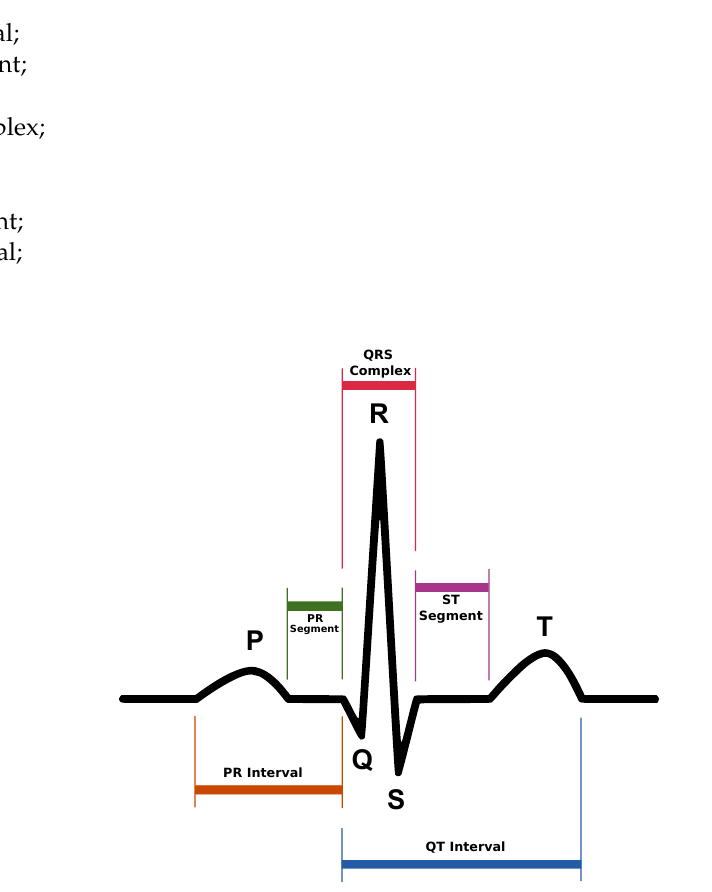
Figure 6. Graphical representation of a heart beat as found in an ECG (created by